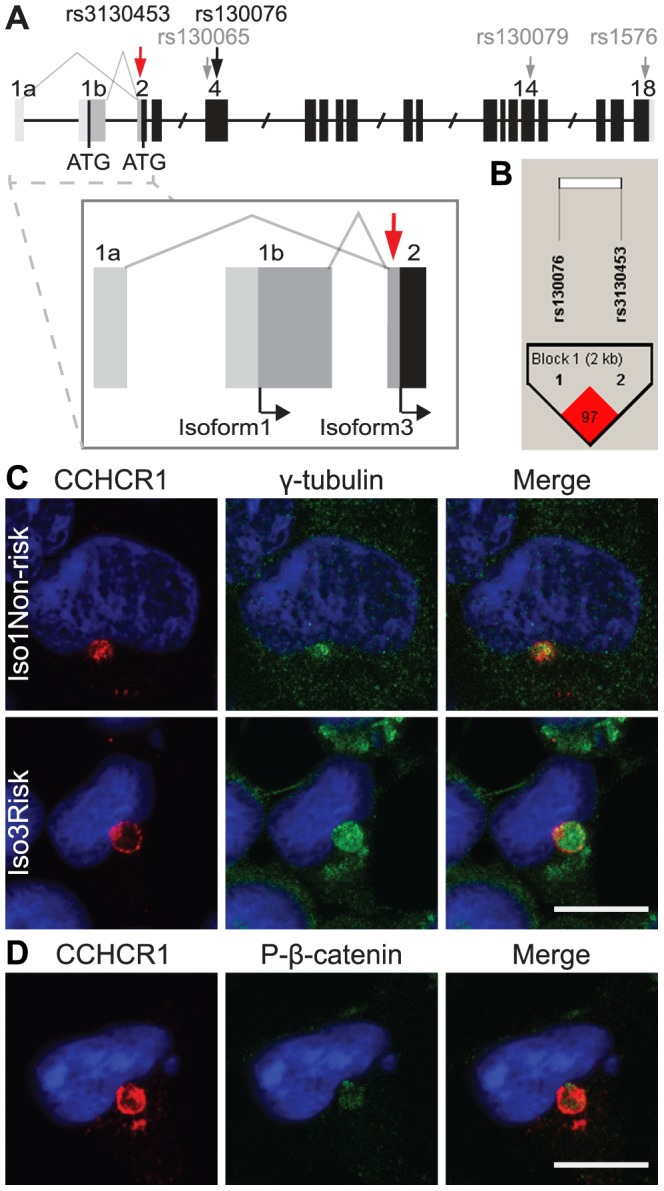
Alternative transcription of CCHCR1 into transcripts 1 and 3 and localization to the centrosome.(A) The numbers represented above the schematic gene structure (not in scale) represent the exons. Transcripts 1 and 3, starting with either exon 1a (transcript 3) or 1b (transcript 1), result from alternative transcription start sites that are featured more clearly in the magnification of the 5′-region. The light grey color represents the untranslated region and the darker grey indicates the sequence for the additional 5′-region in the isoform 1, lacking from isoform 3. The red arrow in exon 2 indicates the SNP (rs3130453) with alleles G and A creating either tryptophan or stop codon, respectively. The former enables the usage of an earlier initiation codon (ATG) in the reading frame. The black and grey arrows show the positions of the WWCC haplotype SNPs in exons 4, 14, and 18. (B) The SNP regulating the 5′ open reading frame (rs3130453, *Iso1/Iso3) and one of the *WWCC SNPs (rs130076, second W) are in high linkage disequilibrium. (C) CCHCR1 localizes in the centrosomal area. Ds-Red-tagged CCHCR1 (red) shows co-localization with the centrosomal marker γ-tubulin (green) in stably transfected HEK293 cells. All CCHCR1 isoforms localize at the centrosome, here shown Iso1Non-risk and Iso3Risk. (D) CCHCR1 also co-localizes with the phosphorylated form of β-catenin at the centrosome. DAPI stained nuclei are shown in blue. Scale bars 10 µm.